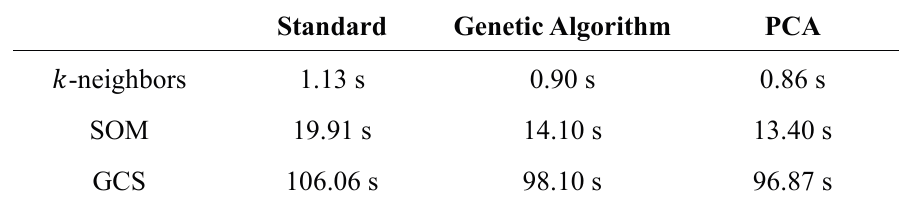
Table 8. Computational cost expressed in terms of execution time (in seconds), considering the weighted moving average (WMA) (Gaussian window with (cid:2026) and the modified scale based normalization (SBN) as a normalization method.